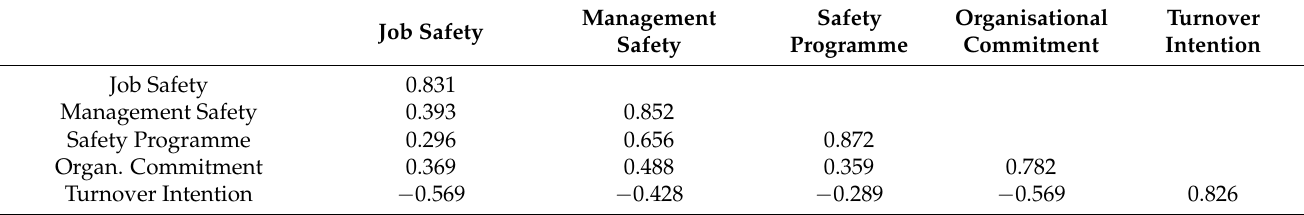
Table 2. Discriminant validity—Fornell–Larcker criterion.